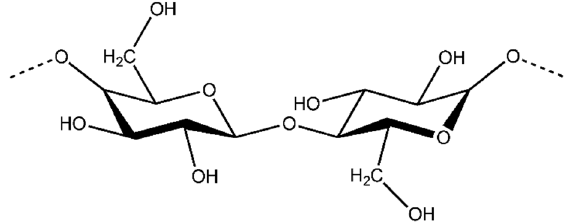
Figure 8. An illustration of the chemical structure of cellulose [80].